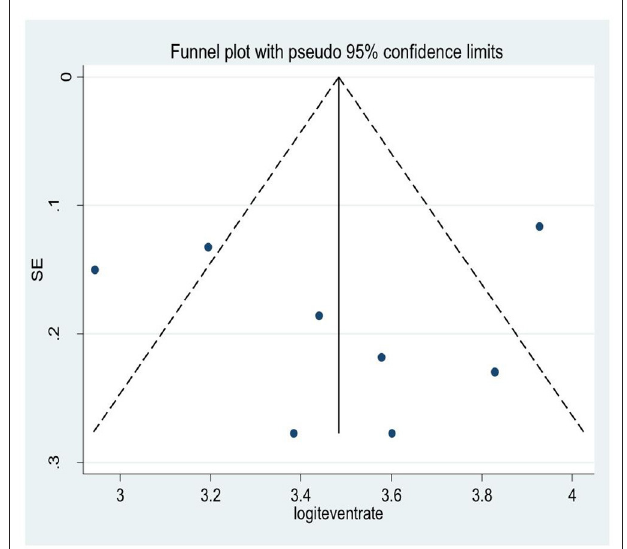
FIGURE 4 | A funnel plot for the systematic review of reviews on depressive symptoms.